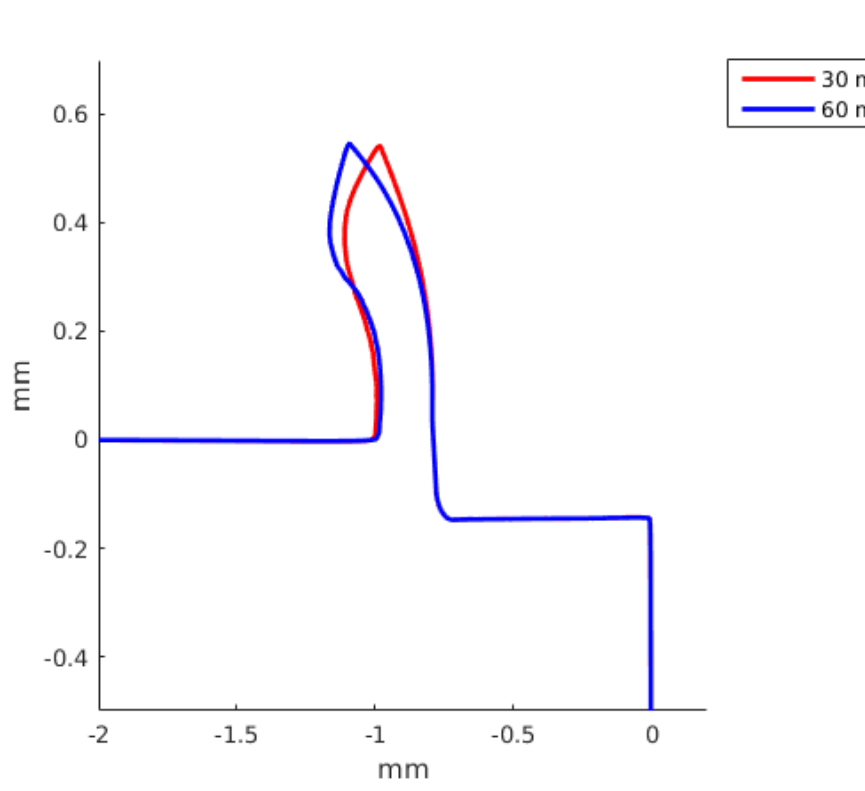
Figure 14. Predicted chip shape at different cutting speeds for the dislocations density model. Feed of 0.15 mm.